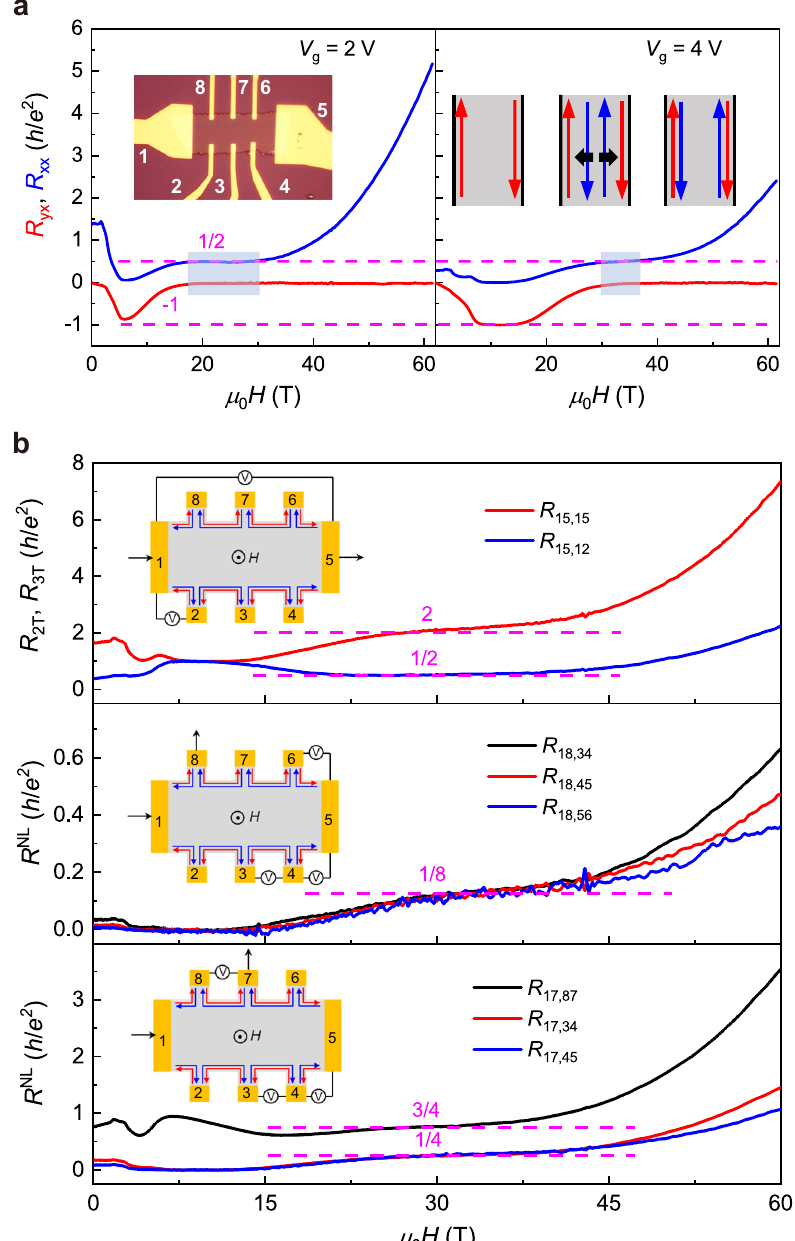
Fig. 4 Signatures of helical edge states transport in multiterminal and nonlocal measurements in the C = 0 phase. a Magnetic fi eld dependent R xx and R yx near the C = − 1 to C = 0 phase transition for V g = 2 V and 4 V. The spatial distribution of edge states in the magnetic fi eld is displayed in the inset. b Two-terminal, three-terminal, and nonlocal measurements in various con fi gurations. The inset shows the schematic layout of the experimental setup. The expected values for R 2 T and R 3 T are 2 h / e 2 and 1/2 h / e 2 , as denoted by the broken lines in the top panels. Middle panel: nonlocal measurements with current fl owing through electrodes 1 and 8. The convergence of all three curves near 1/8 h / e 2 (denoted by the broken lines) indicates the helical edge transport at the onset of the C = 0 phase. Bottom panel: nonlocal measurements in another setup with current fl owing through electrodes 1 and 7. Depending on the position of the voltage probes, the resistance values of 1/4 and 3/4 h / e 2 are expected, which are con fi rmed by the experimental Device fabrication . MnBi 2 Te 4 fl akes were mechanically exfoliated onto 285 nm- with 7-SL and 6-SL MnBi 2 Te 4 denoted as device #7-SL-1, #7-SL-2, #7-SL-3 and #6- thick SiO 2 /Si substrates by using the Scotch tape method. Before exfoliation, all SL-1 were measured in a pulsed magnetic fi eld. The data shown in the main fi gures are taken from device #7-SL-1, and that of other devices are documented in SiO 2 /Si substrates were pre-cleaned in air plasma for 5 min with ~125Pa pressure. Supplementary Fig. 1 to Fig. 11. Thick fl akes around the target sample area were manually scratched off by using a sharp needle. A 270 nm thick Poly(methyl methacrylate) (PMMA) layer was spin- coated on the exfoliated fi lm before electron-beam lithography (EBL). After the Transport measurement . High- fi eld electrical transport measurements were EBL, 53nm thick metal electrodes (Cr/Au, 3/50nm) were deposited using a performed in a 4 He cryostat with a base temperature of 2K in Wuhan National thermal evaporator connected to an argon- fi lled glove box with the O 2 and H 2 O High Magnetic Field Center. A pulsed DC current of 4 μ A was generated by a levels lower than 0.1 PPM. Throughout the fabrication and sample transfer process, Yokogawa GS610 current source. An uncertainty of 250 Ω arising from the high the device was covered by PMMA to avoid direct contact with air. Four devices